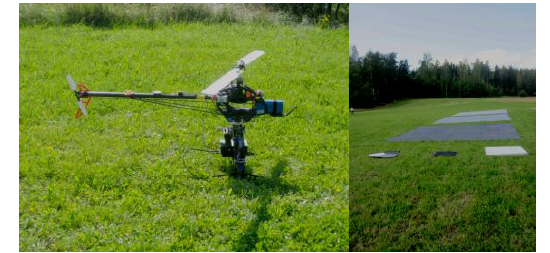
Figure 3. The FPI spectral camera in a helicopter UAV. Right: Radiometric reference targets in the campaign area. Table 1. Parameters of the UAV flight on 16.8.2012 Flight 1. Area 1, Filter: 500-900 nm, Exposure: 14 ms, 42